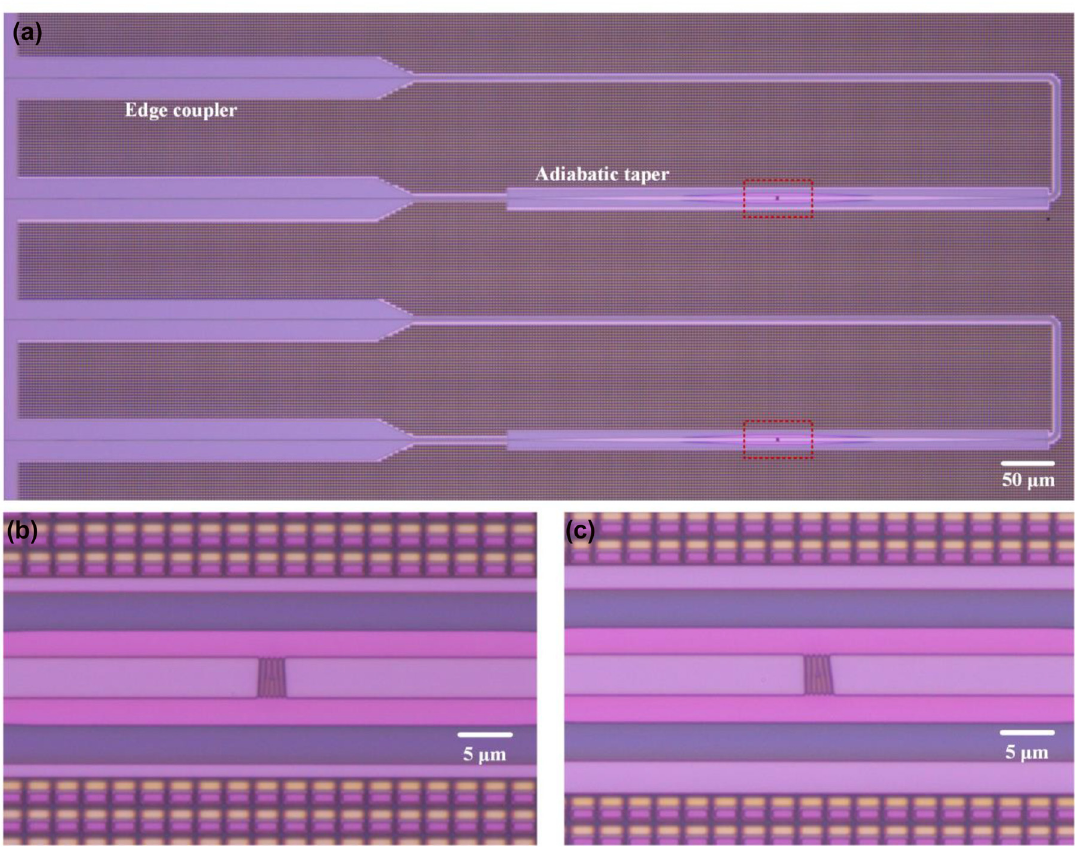
Figure 9: Fabricated devices. (a) Measured optical microscope images of the devices. (b, c) Measured optical microscope images of conventional and tilt subwavelength holographic surface fork